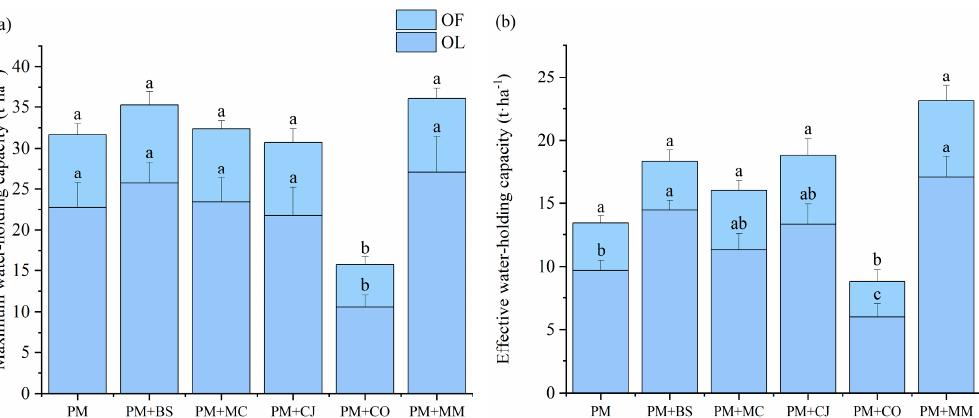
Figure 1. Comparison of maximum water-holding capacity ( a ) and effective water–holding capacity ( b ) of litter in different forest types. Note: OF: semi-decomposed litter; OL: undecomposed litter. The lowercase letters illustrate significant differences among different forest types in the same litter layer ( p < 0.05). Pinus massoniana (PM), Bretschneidera sinensis (BS), Manglietia chingii (MC), Cercidiphyllum japonicum (CJ), Camellia oleifera (CO), and Michelia maudiae